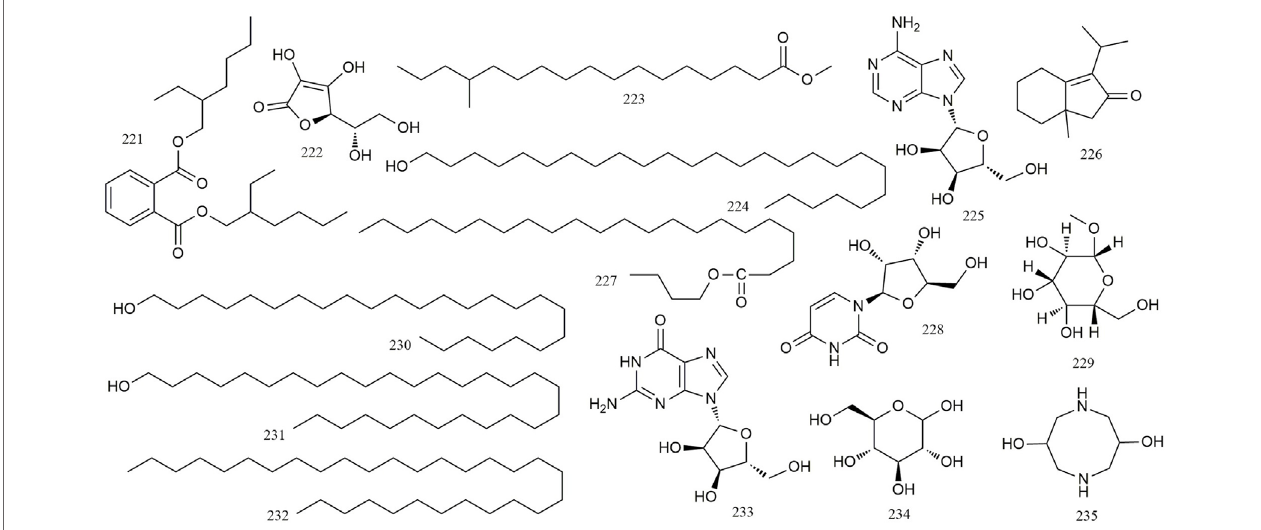
FIGURE 9 | Chemical structures of other compounds (221–235) isolated from R. chingii